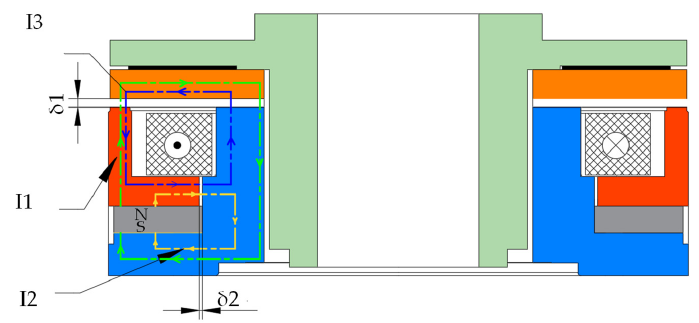
Figure 1. Structure of brakes. ( a ) Non-excited brake. ( b ) High-torque permanent magnet brake. ( c ) Three-dimensional explosion diagram of a permanent magnet brake. 1. Yoke iron. 2. Spring. 3. Friction plate. 4. Flange. 5. Disc armature. 6. Coil. 7. Inner yoke iron. 8. Permanent magnet. 9. Outer yoke iron. 10. Plate spring.